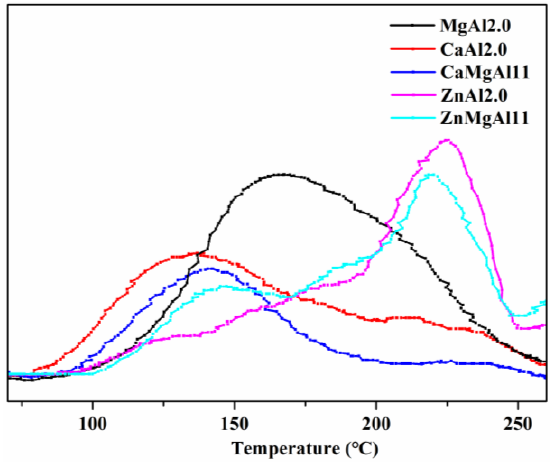
Figure 3. CO 2 -TPD profiles of LDHs with varying metal elements in the laminae. Table 1. Desorption peak temperature and area of LDHs with different metal elements in laminae. LDHs Temperature/ ◦